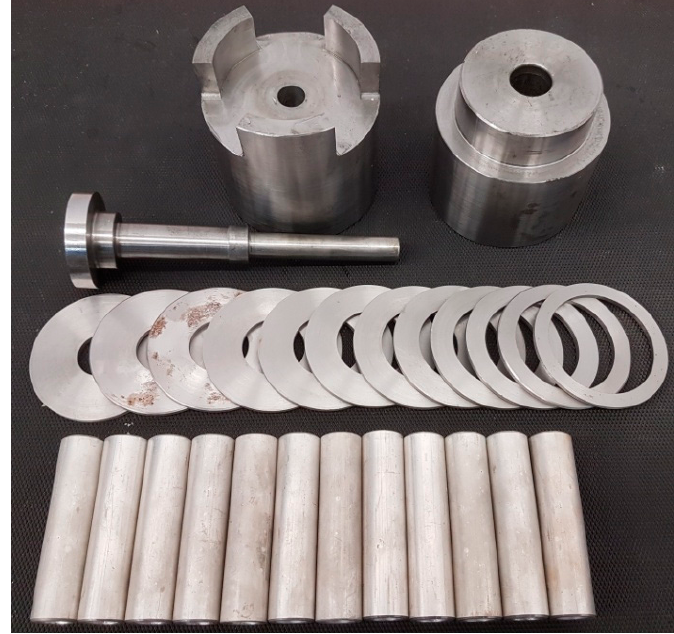
Figure 2. Tools and billets used in the incremental radial extrusion of the flange.